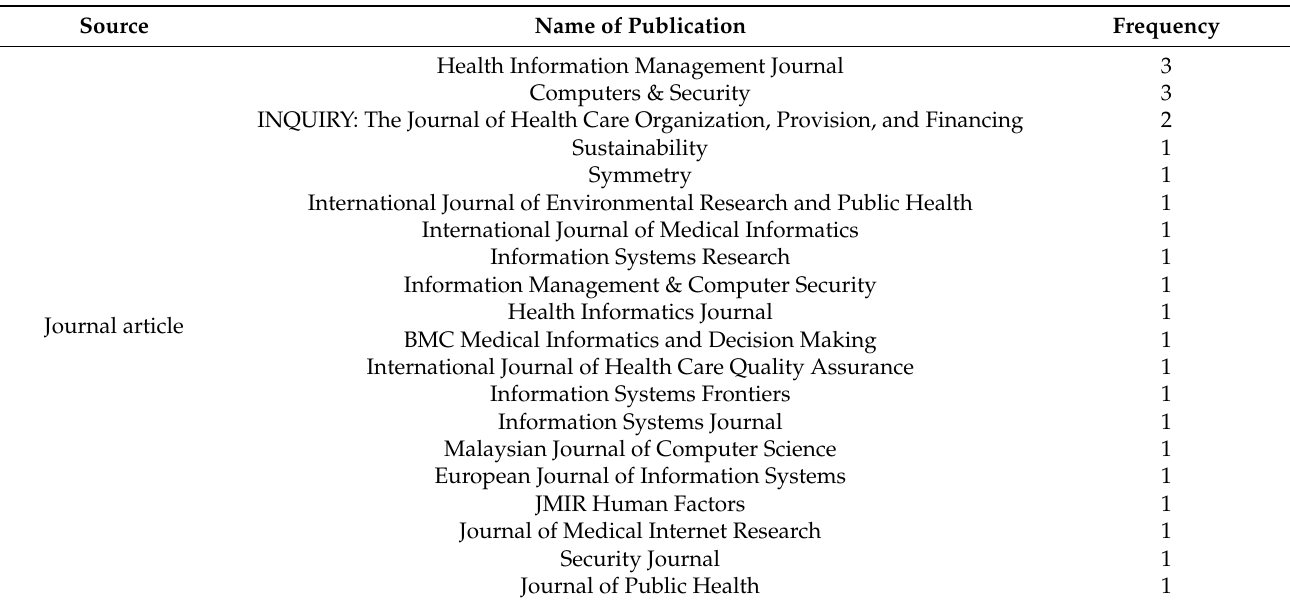
Table 5. Source of the selected